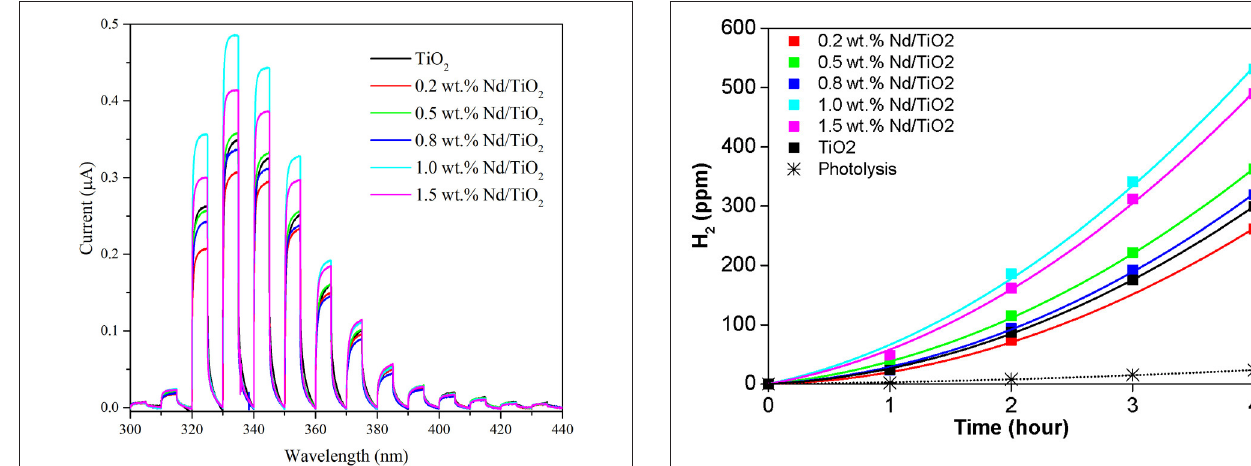
FIGURE 7 | Generation of hydrogen in the photocatalytic oxidation of methanol in the presence of Nd/TiO 2 and parent TiO 2 photocatalysts.